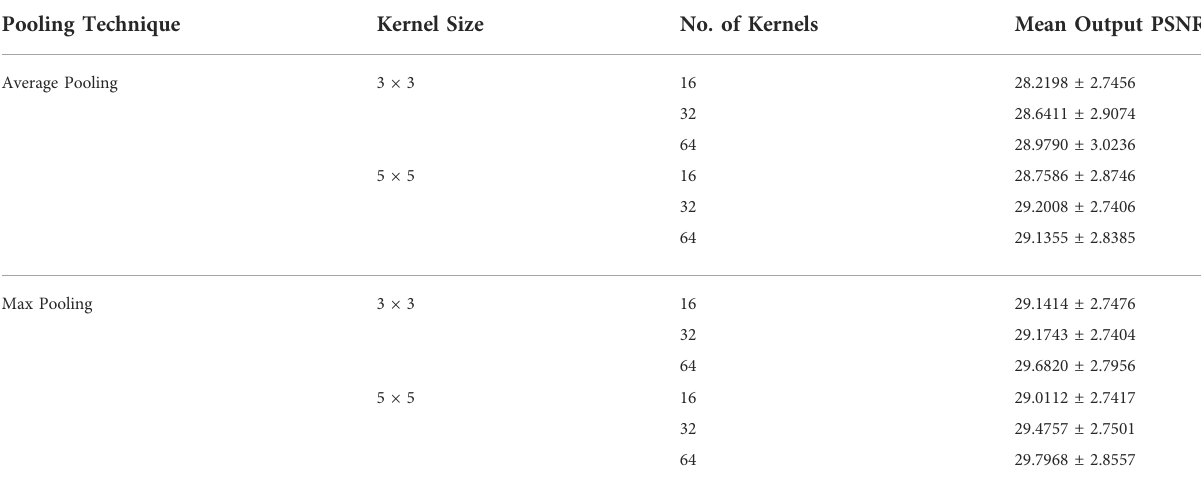
TABLE 5 Mean PSNR results for the ablation study on the effect of different pooling techniques on the model performance. (Mean input PSNR = 13.3726 ± 0.9174). Pooling Technique